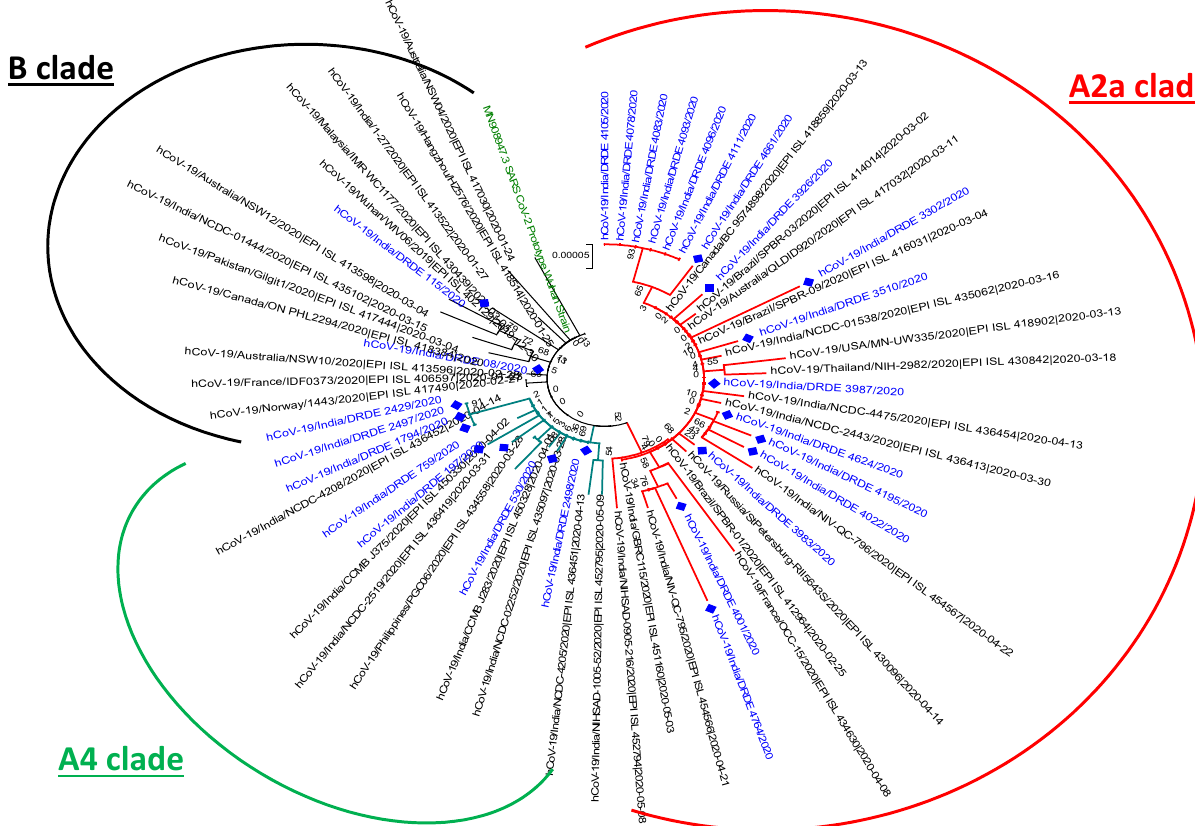
Figure 3. Phylogenetic analysis of Indian SARS-CoV-2 sequenced in this study. The virus sequence in this study were highlighted with blue